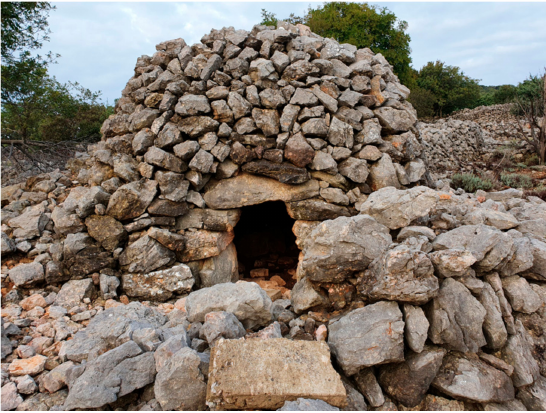
Figure 24. Dry stone shelters with round plans and stone roofing are considerably less frequent and less known on the islands of Cres and Lošinj in comparison to the rest of the Croatian coast (Tanja Kremeni´c, 2020).